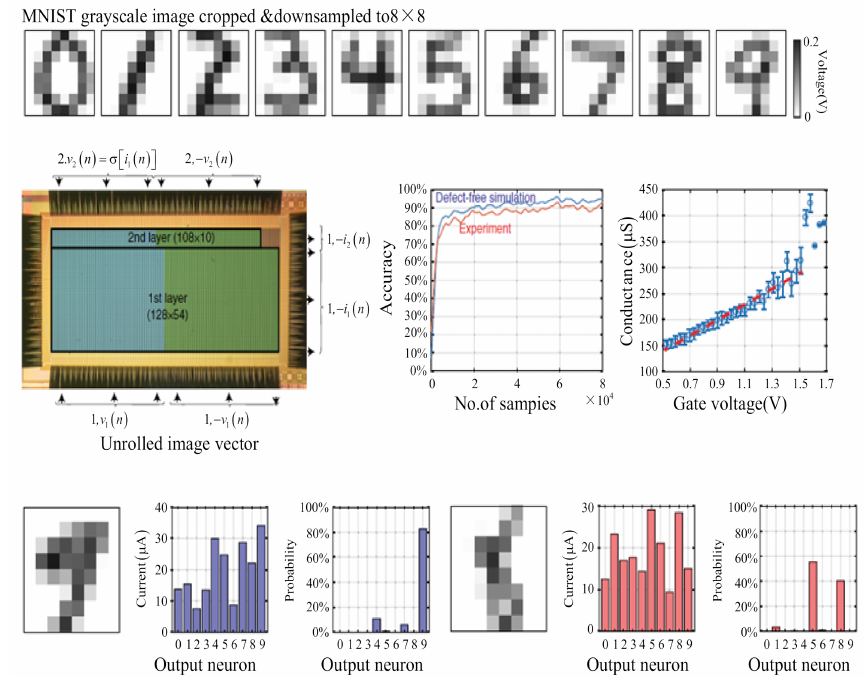
Figure 11. Handwriting recognition based on the ReRAM